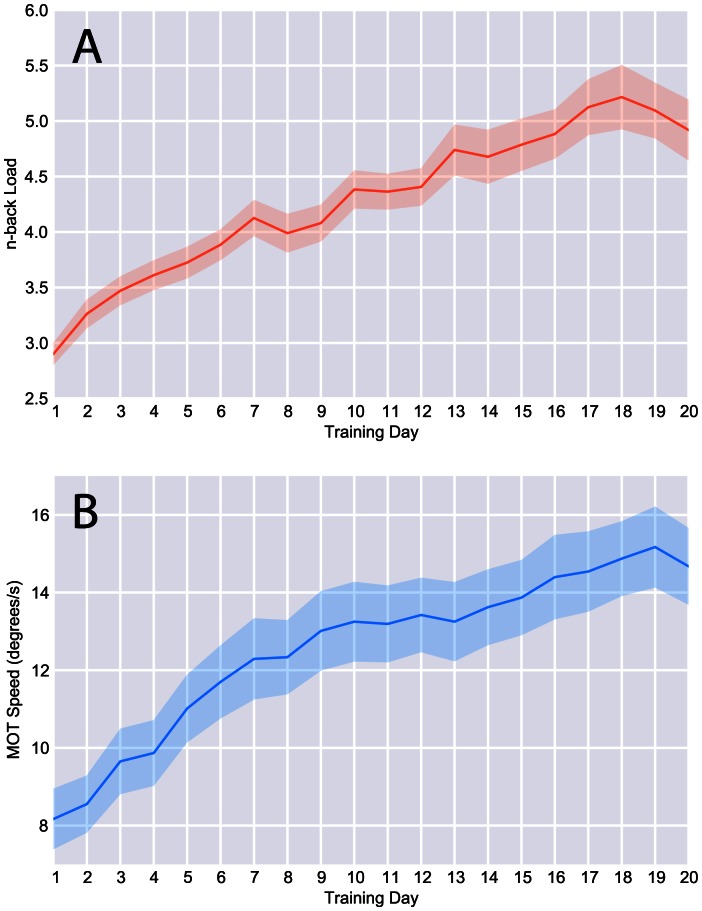
Performance across training sessions.
A) Mean dual n-back load and B) mean multiple object tracking speeds achieved per session of training are displayed. Shaded area represents standard error of the mean.